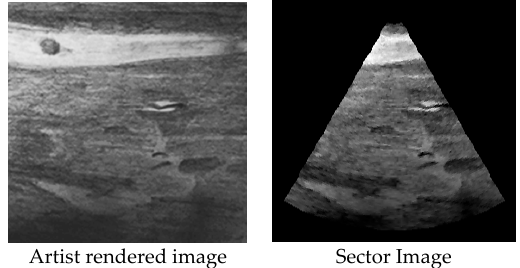
Figure 2. Artist rendered synthetic image and its cropped version using a sector region.